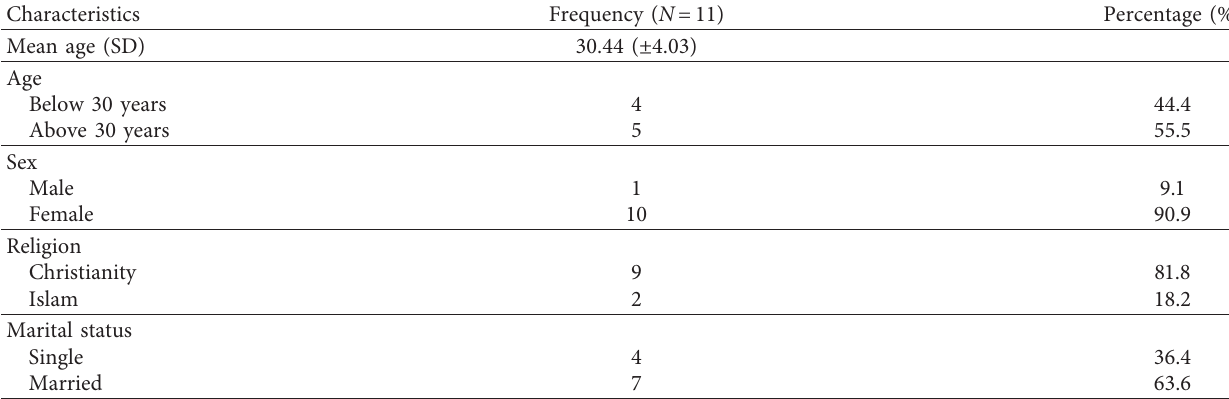
Table 3: Demographic characteristics of CHN.